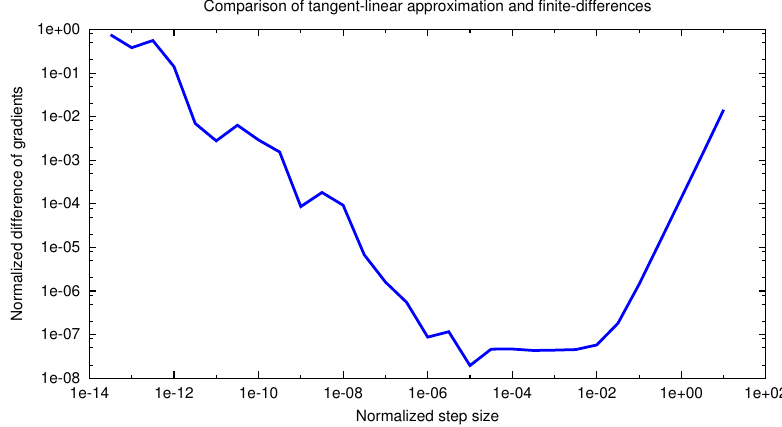
Fig. 1. Difference of the gradient of the observational cost function for the contribution of a single ray evaluated in the tangent-linear approximation to finite differencing of the non-linear operator as a function of step